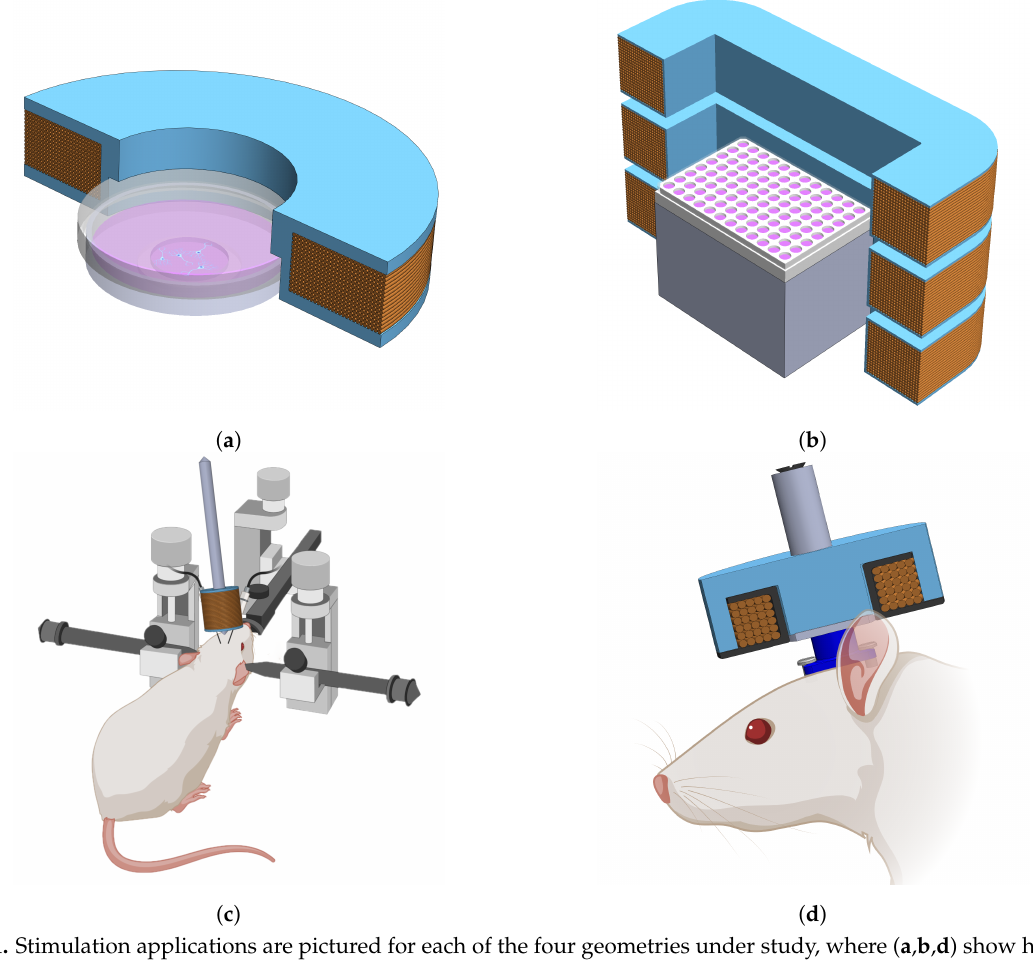
Figure 1. Stimulation applications are pictured for each of the four geometries under study, where ( a , b , d ) show half of the coils for improved visualization. ( a ) A coil designed to fit over top of a 35 mm culture dish which can be used for microscopy; ( b ) a set of three coils which can be stacked and used for stimulating samples on a multi-well plate with a relatively uniform field; ( c ) an application of an electromagnet for head-fixed electrophysiology; ( d ) a coil wound onto a bobbin and inserted into a pot core which could be used for freely behaving animal studies. Created in part using